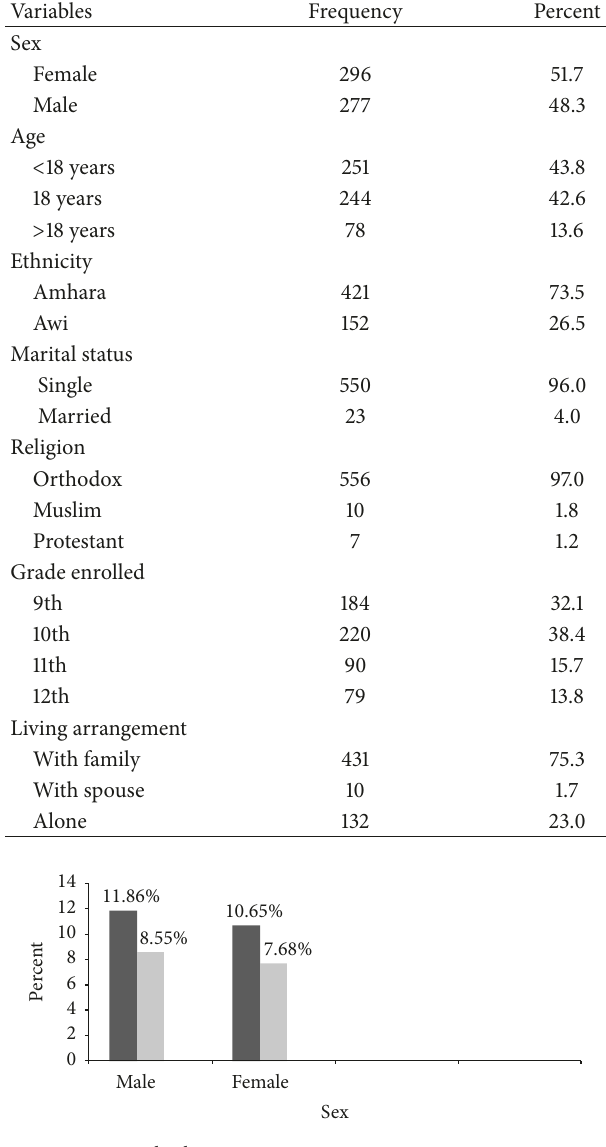
Table 1: Distribution of sociodemographic characteristics of ado- lescent high school students in Dangila Town, Northwest Ethiopia,